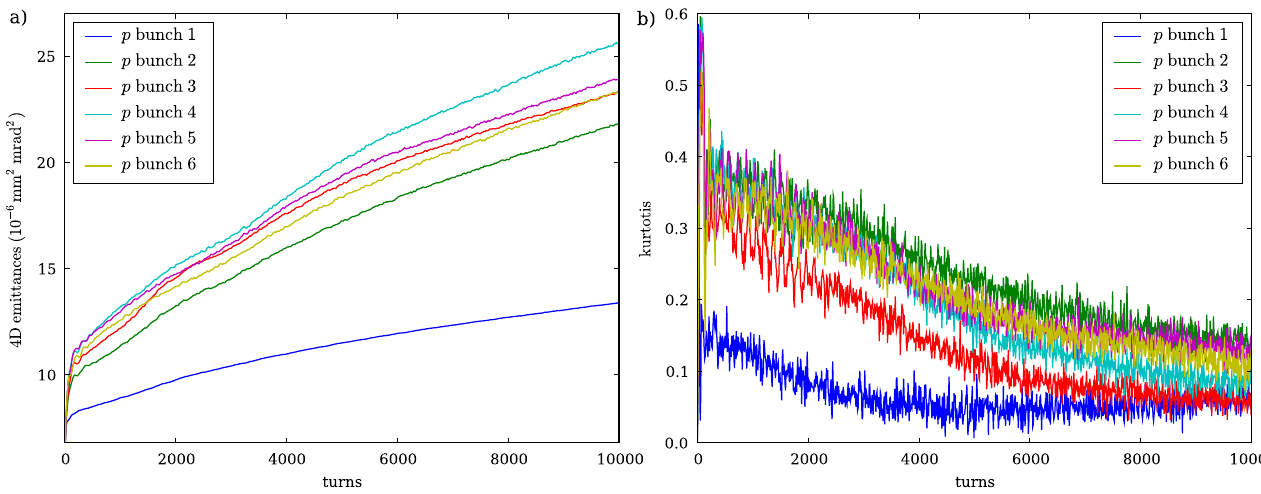
FIG. 15. (Color) In a six-on-six bunch Tevatron run with 8 : 8 (cid:2) 10 11 particles/bunch, with the beam spacing at the first parasitic IP downstream of the head-on location artificially increased: (a) The 4D emittance of each of the six bunches as a function of turn; (b) the y kurtosis of the six bunches as a function of